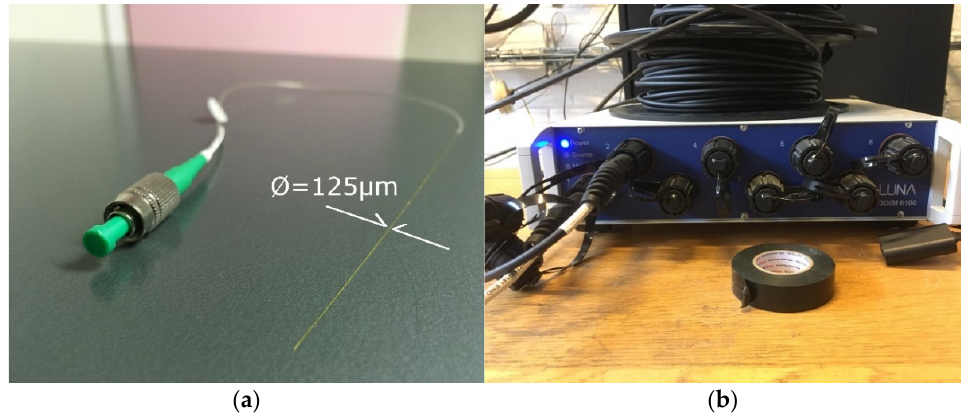
Figure 3. ( a ) Distributed OFS (DOFS) fiber and ( b ) ODiSI-6000 model Optical Backscatter Reflec- tometer (OBR) interrogator manufactured by LUNA